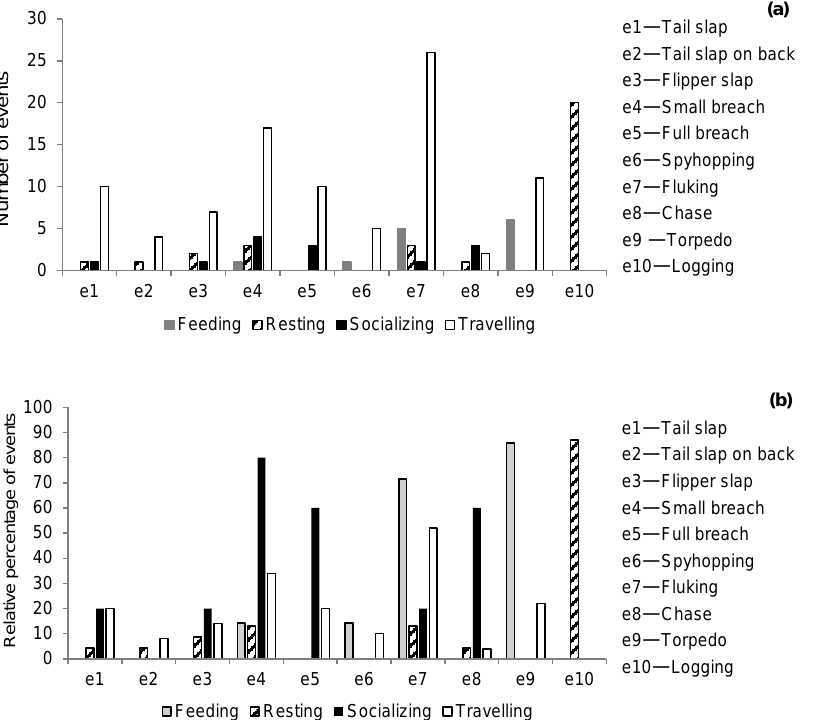
Figure 4. ( a ) Type and number of behavioral events recorded during 98 sightings of Risso’s dolphin occurred in the Gulf of Taranto from 2019 to 2021; ( b ) relative percentage of behavioral events for each activity state recorded.